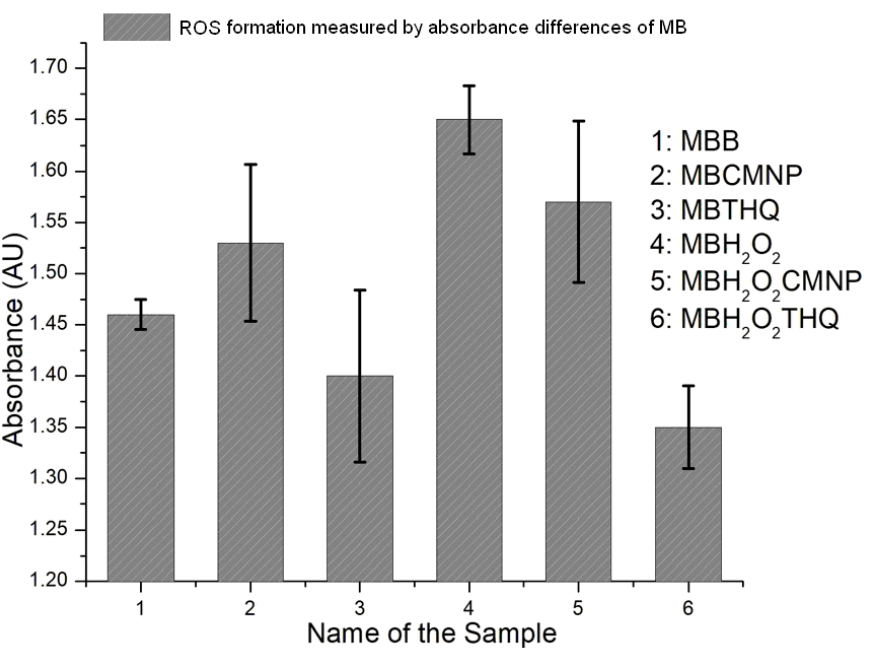
Figure 6. ROS formation measured by absorbance differences of methylene blue (MB). Error bars indicate standard deviation.